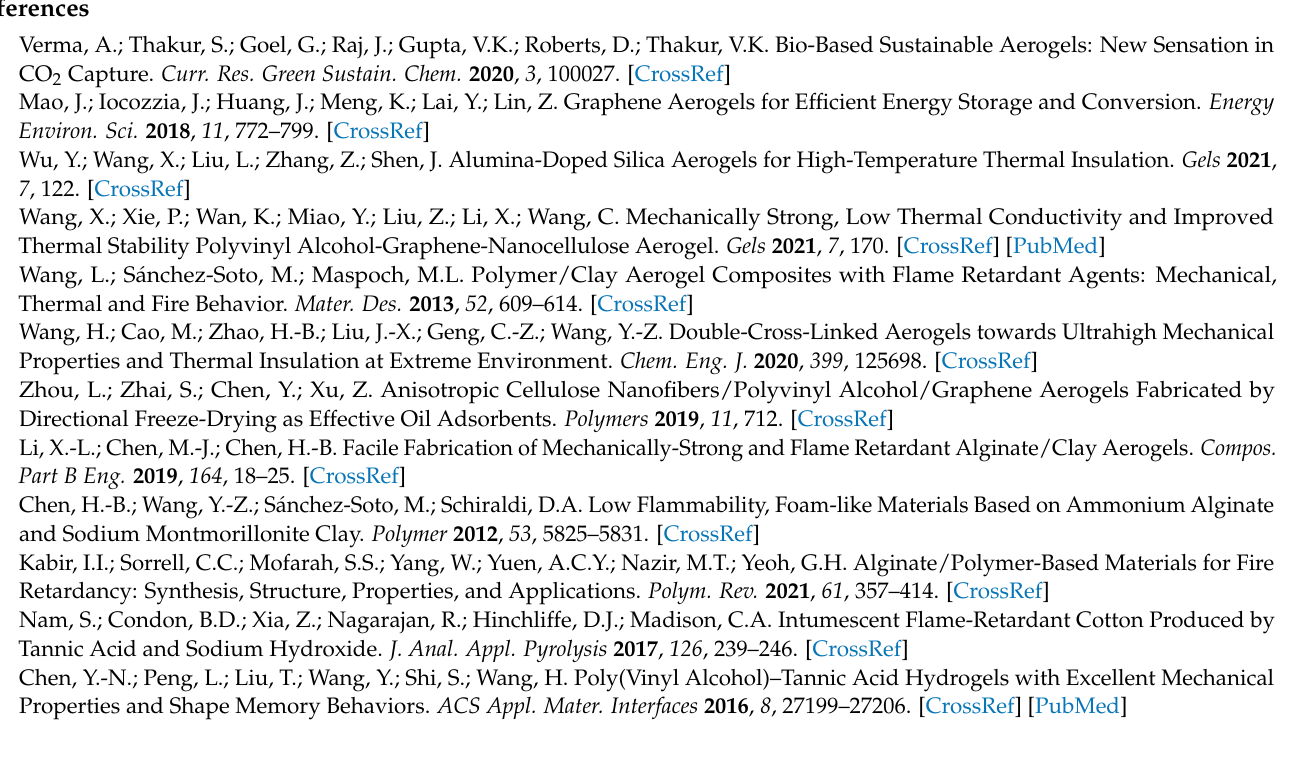
aerogels; Figure S4: Thermal degradation behavior of (a) uncrosslinked and (b) crosslinked aerogels; Figure S5: HRR curves of (a) uncrosslinked and (b) crosslinked PVA/TA/SA aerogels; The